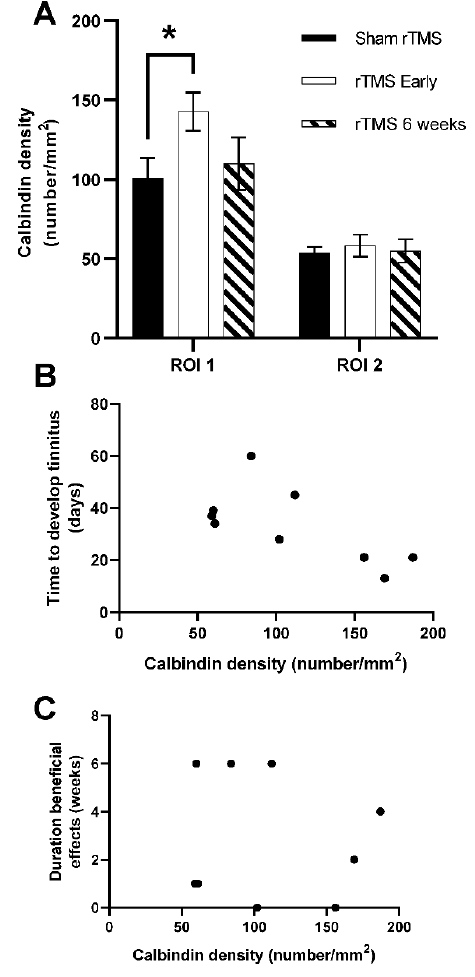
Figure 5. Data on density of calbindin-positive neurons. ( A ): Bar graph showing densities of calbindin-positive neurons in two regions of interest (RO1 and RO2) in PFC comparing the result from the present study, 6 weeks after the cessation of treatment (rTMS 6 weeks) with data collected previously from sham rTMS treatment and soon after rTMS treatment (3 days after the cessation of treatment) [33]. A significant upregulation soon after rTMS treatment ( p = 0.0383; indicated with *) was observed only in the most dorsal region (RO1) but densities returned to sham levels 6 weeks after cessation of treatment (current data). ( B ): Scatterplot showing significant correlation from data in current study between calbindin density and time it took to develop tinnitus (Pearson correlation analysis, p = 0.0457). ( C ). Scatterplot from data in the current study showing lack of correlation between calbindin density and duration of beneficial effects on tinnitus (Pearson correlation analysis; p =